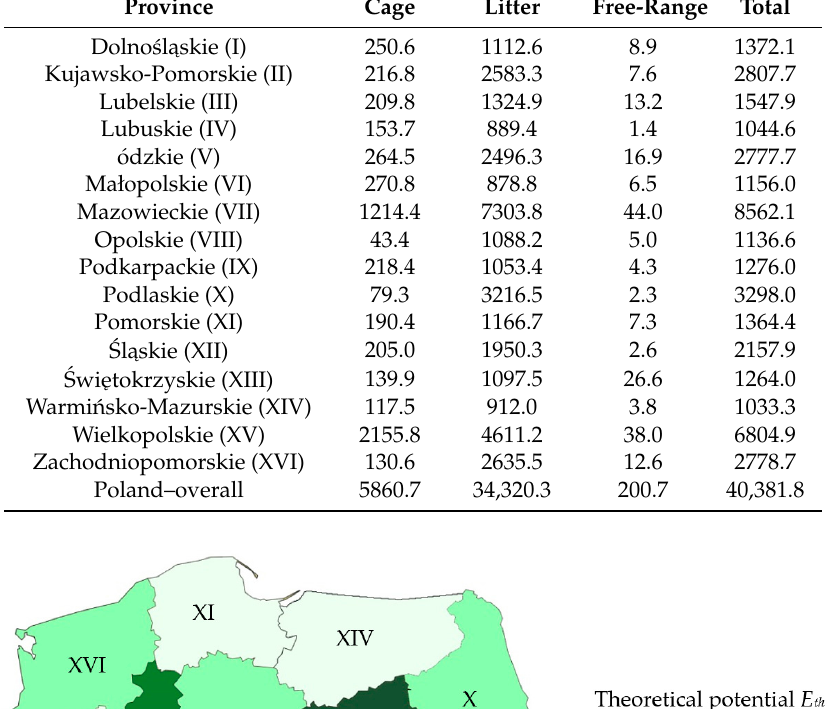
Table 7. Annual theoretical energy potential of chicken manure in Poland, E th in TJ.